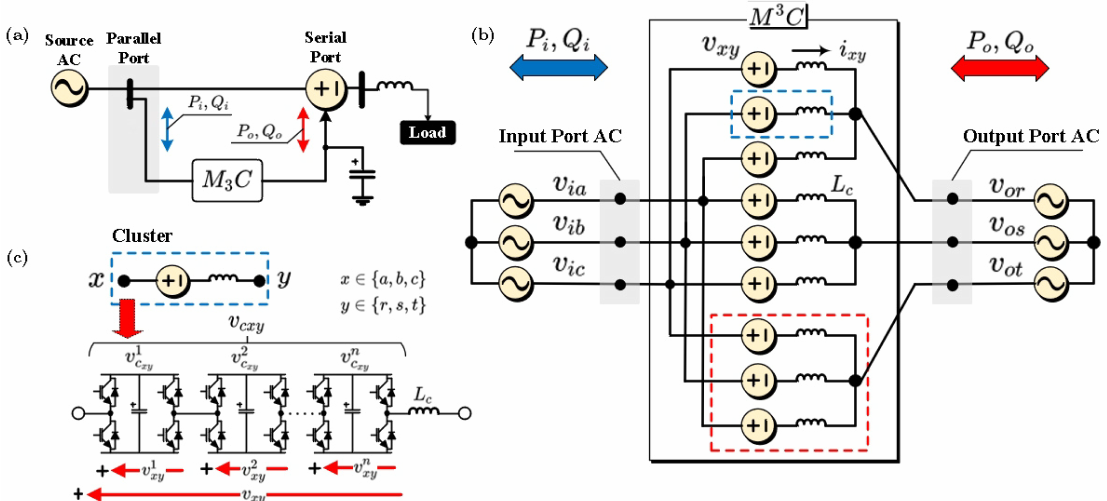
Figure 1. ( a ) Proposed Modular Multilevel Matrix Converter ( M 3 C )-Unified Power Flow Controller (UPFC) topology. ( b ) M 3 C topology. ( c ) Cluster